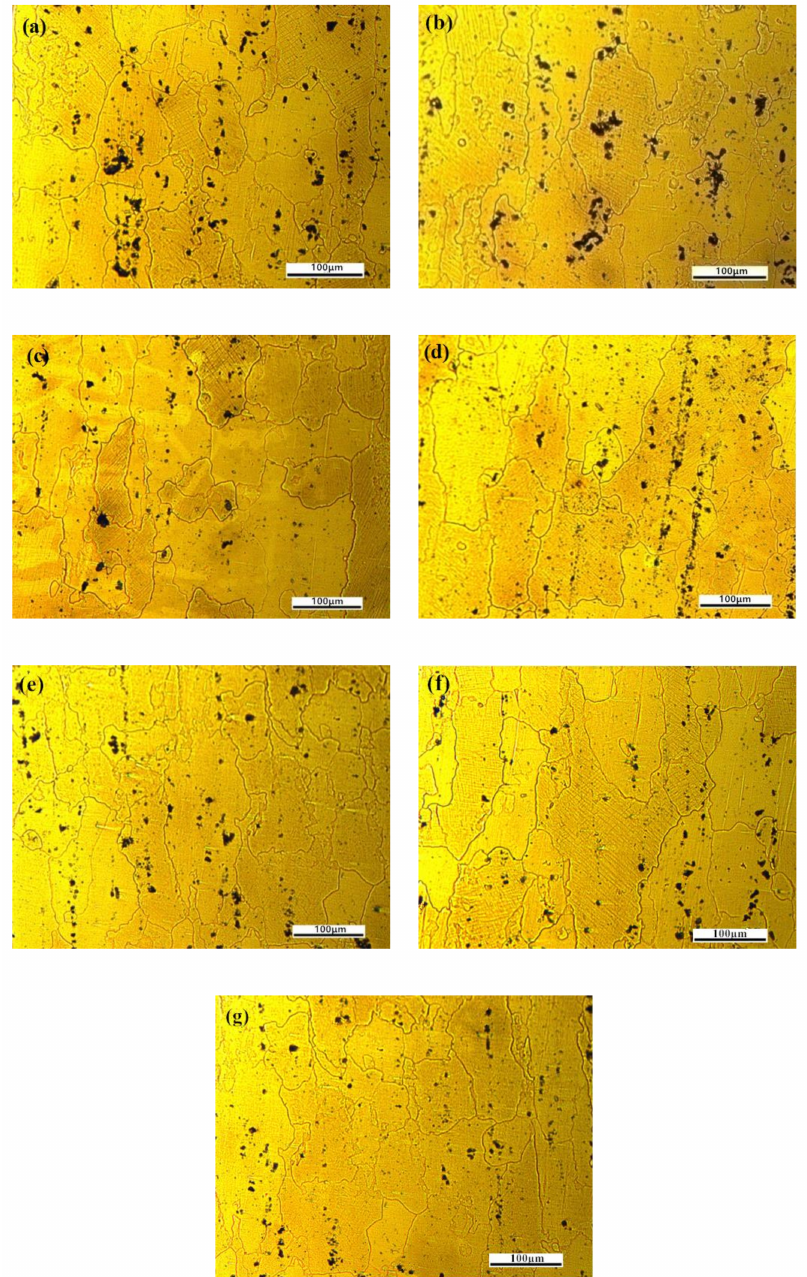
Figure 2. Microstructure of 7075 alloy with different cryogenic treatment (CT): ( a ) 25 ◦ C; ( b ) 0 ◦ C; ( c ) − 60 ◦ C; ( d ) − 120 ◦ C; ( e ) − 196 ◦ C; ( f ) − 60 ◦ C (twice); and ( g ) − 120 ◦ C